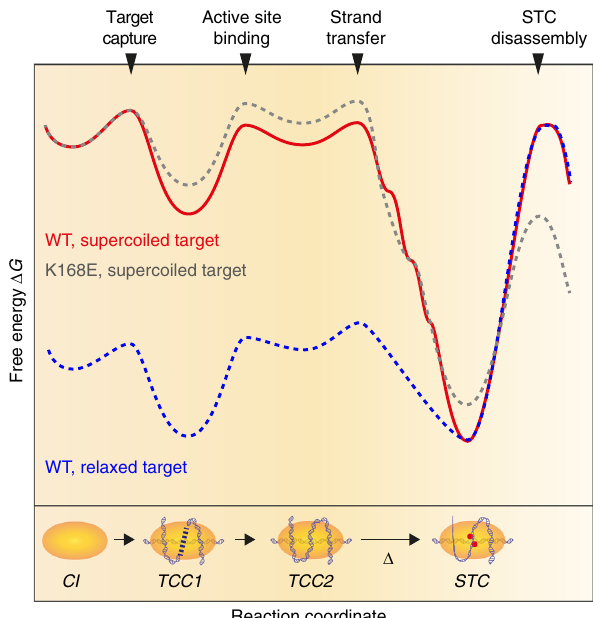
Fig. 6 Model of the integration energy landscape. Target capture occurs in two stages and is virtually irreversible yet dynamic, owing to multivalent binding at auxiliary interfaces that form independent of the sign of target DNA supercoiling. Active site binding requires severe DNA deformation and is rate-limiting with respect to strand transfer. Strand transfer is irreversible due to stepwise release of mechanical strain in the target and results in an allosteric conformational change ( Δ ) that stabilizes auxiliary interfaces in a torque-dependent manner. Target binding at apical interfaces mechanically shields the DNA in the active site and renders STC disassembly extremely